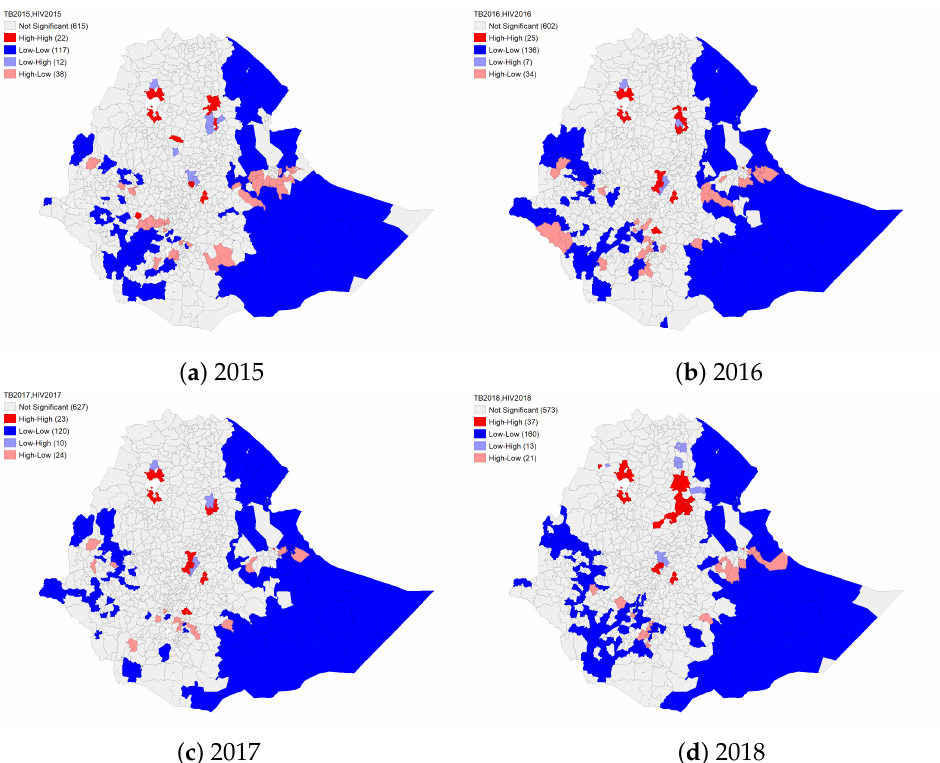
Figure 3. Spatial co-clustering of HIV and tuberculosis in Ethiopia at the district level from 2015 to 2018 using the binary local Moran’s I